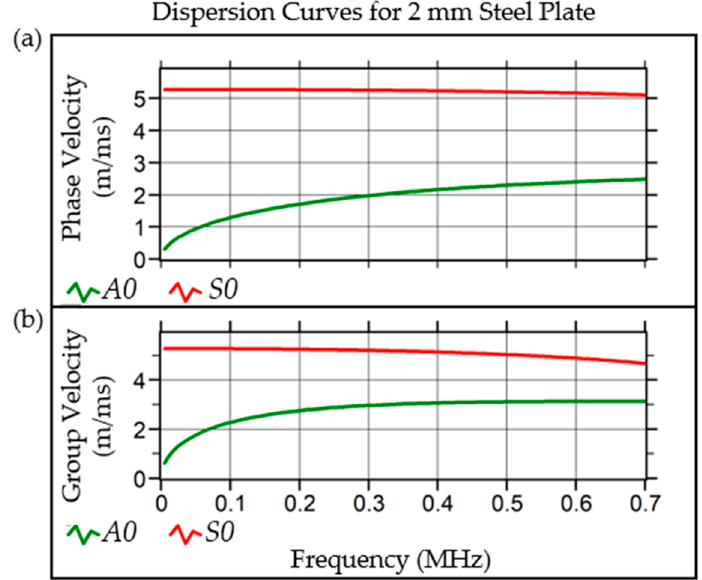
Figure 7. Plots of ( a ) phase velocity and ( b ) group velocity dispersion curves for the 2 mm steel plate used in Case P1, generated using Vallen Dispersion software